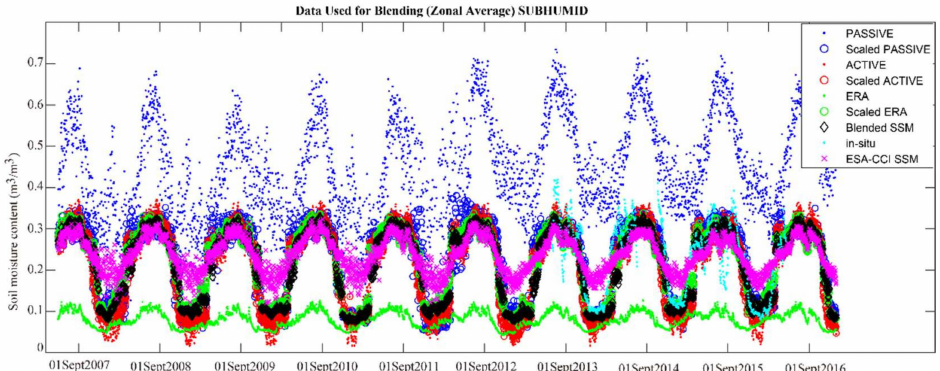
Figure 5. Time Series Diagrams of original PASSIVE product, original ACTIVE product, Scaled PASSIVE product, scaled ACTIVE product, Blended SSM product, in-situ Tibet-Obs product, and ESA-CCI SSM product. (A zonally averaged data over Sub-humid region).